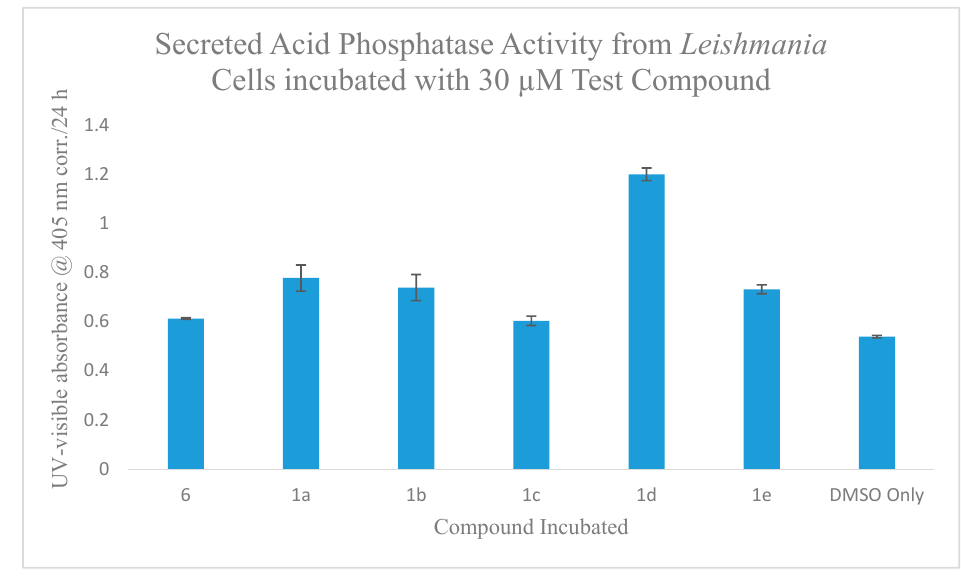
Figure 5. Absorbance (A 405 nm) after 24 h incubation with p NPP. Values are mean ± SD for n = 4 replicates.